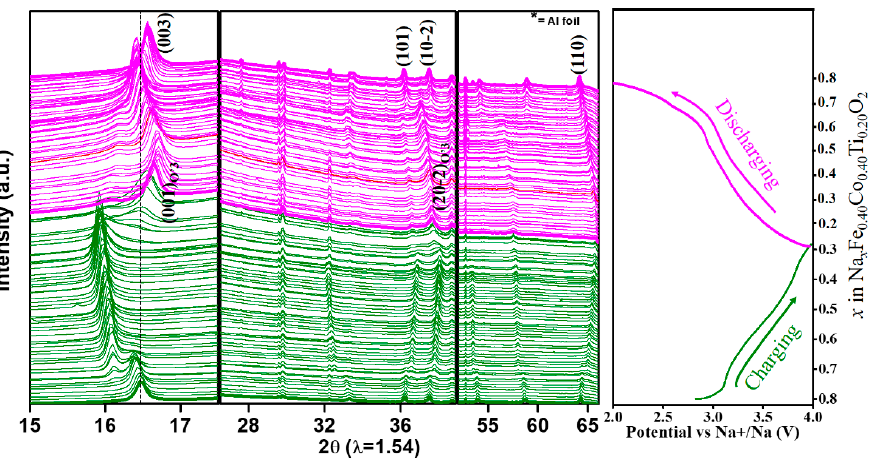
Figure 3. In situ XRD patterns for NFCTO electrode during the first charge and discharge at 0.1C in the voltage range of 2.0–4.0 V vs. Na + /Na .